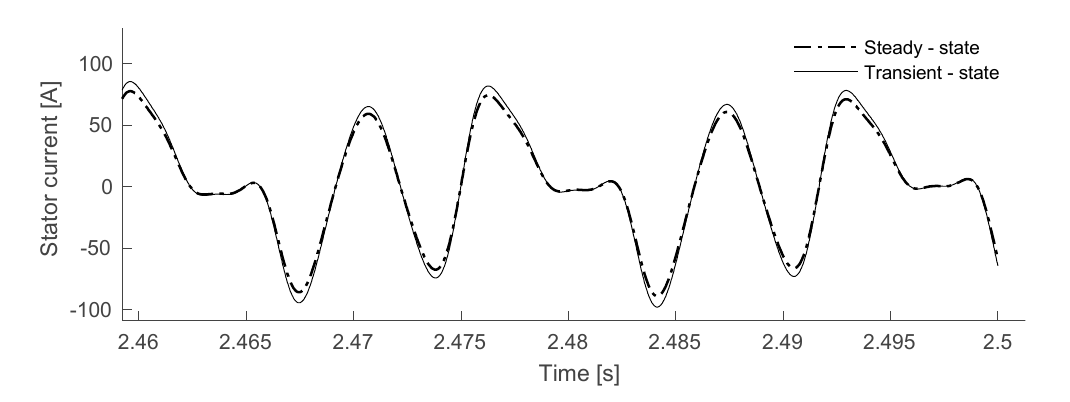
Figure 13. Stator Figure 13. Stator current.